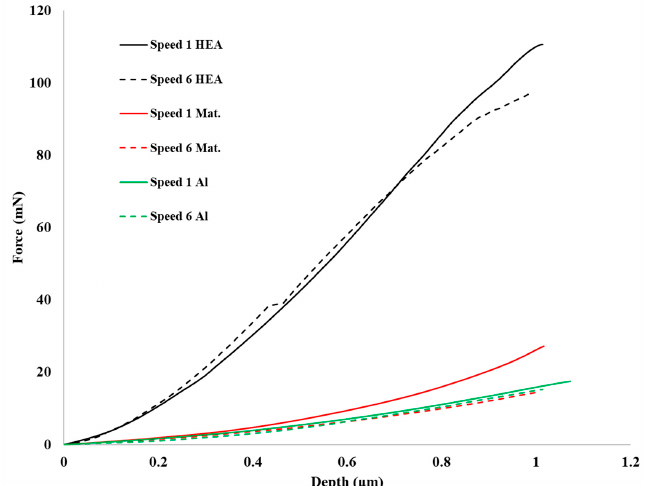
Figure 5. Loading stages for HEA, matrix, and pure aluminum at two different speeds.